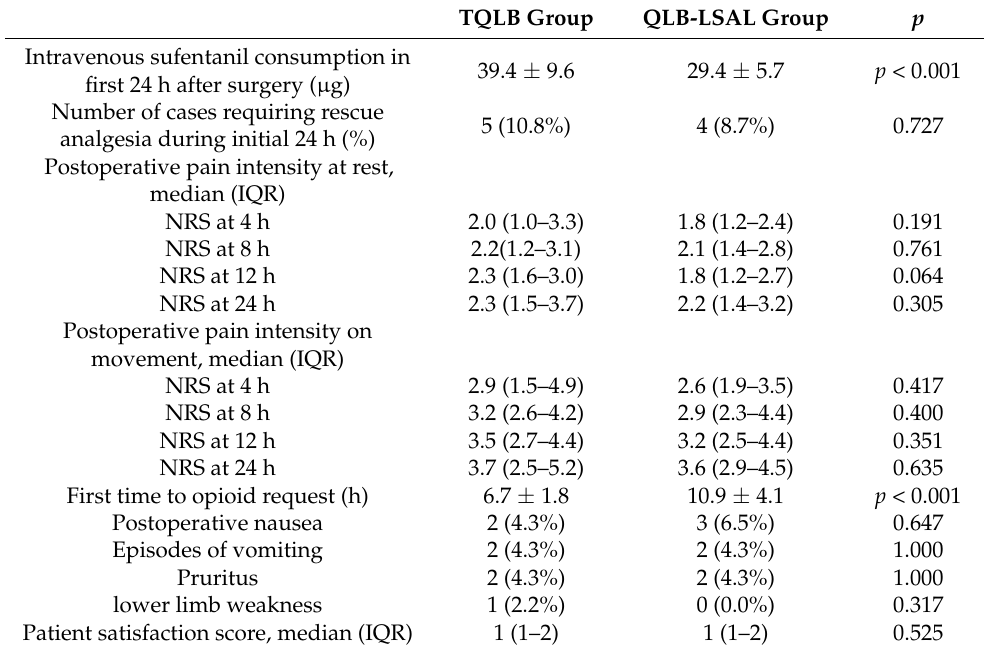
Table 2. The postoperative